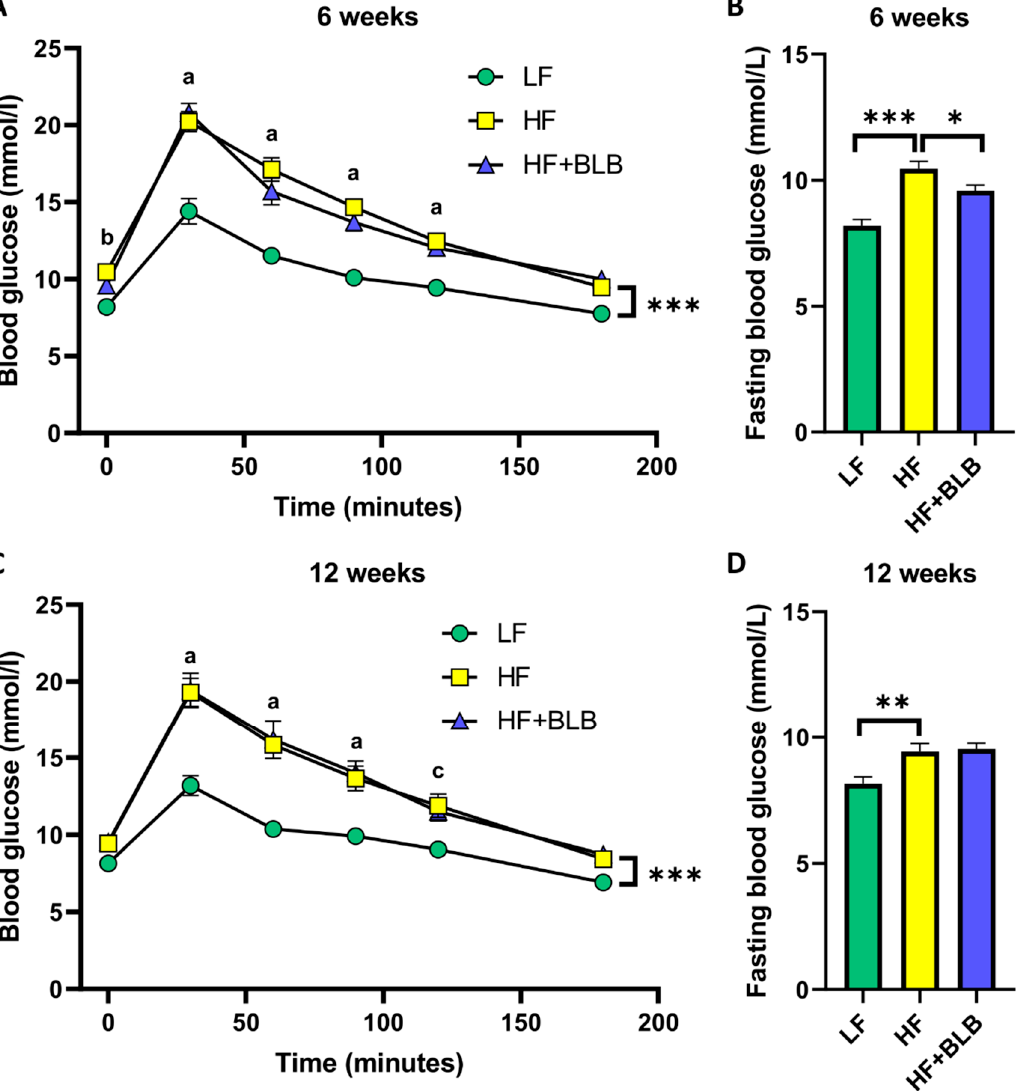
Figure 4. Intraperitoneal glucose tolerance test (IPGTT) and fasting blood glucose levels. The mice received a low-fat diet (LF, 10% of energy from fat, circle), a high-fat diet (HF, 46% of energy from fat, square) or a bilberry-supplemented high-fat diet (HF+BLB, 20% air-dried bilberry powder, tri- angle) for six ( A , B ) or twelve ( C , D ) weeks. The IPGTT was carried out a week before the end of each experiment, i.e., at weeks five ( A ) and eleven ( C ). The IPGTT data ( A , C ) was analyzed with a two- way (mixed model) ANOVA and a Bonferroni multiple comparisons test. The statistically signifi- cant difference between the HF and LF groups in each week is marked as a = p < 0.001, b = p < 0.01, and c = p < 0.05. The fasting glucose data ( B , D ) was analyzed with a one-way ANOVA and a